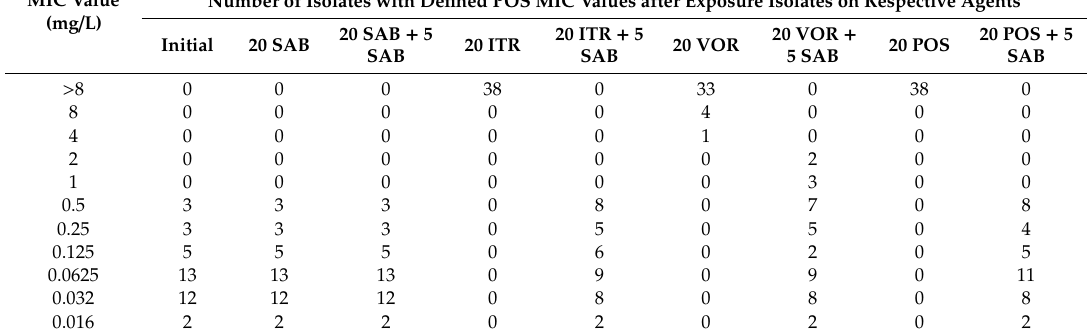
Table 5. The e ff ects of exposure to subinhibitory concentrations of ITR, VOR or POS on the MIC values for the respective agents.